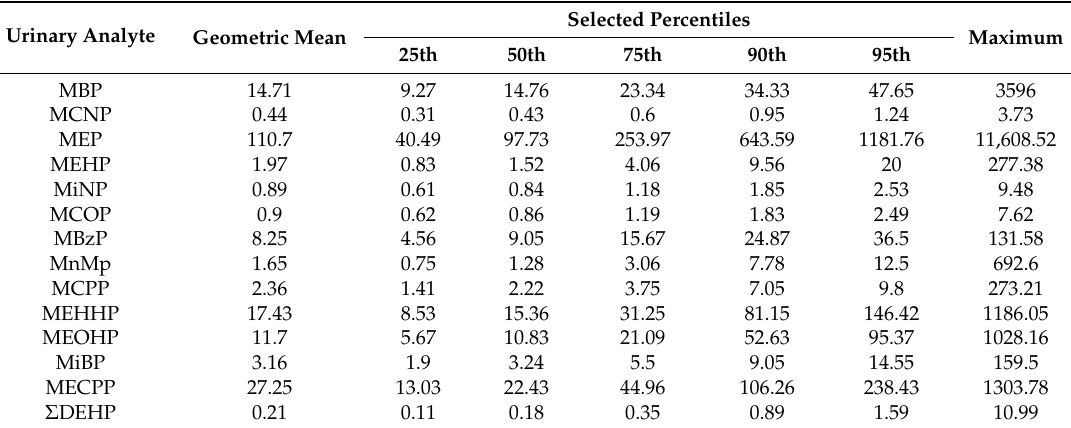
Table 4. Unweighted, creatinine-corrected urinary phthalate metabolites ( µ g/g Creatinine) in males, NHANES 2003–2004. Urinary Analyte Geometric Mean